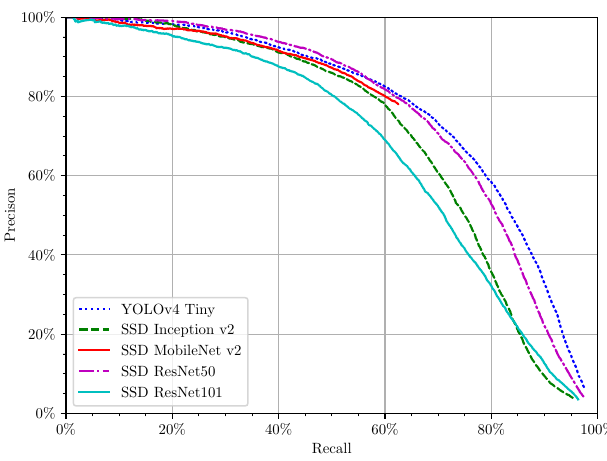
Figure 11. Precision × recall curve in the test set considering all the predictions.